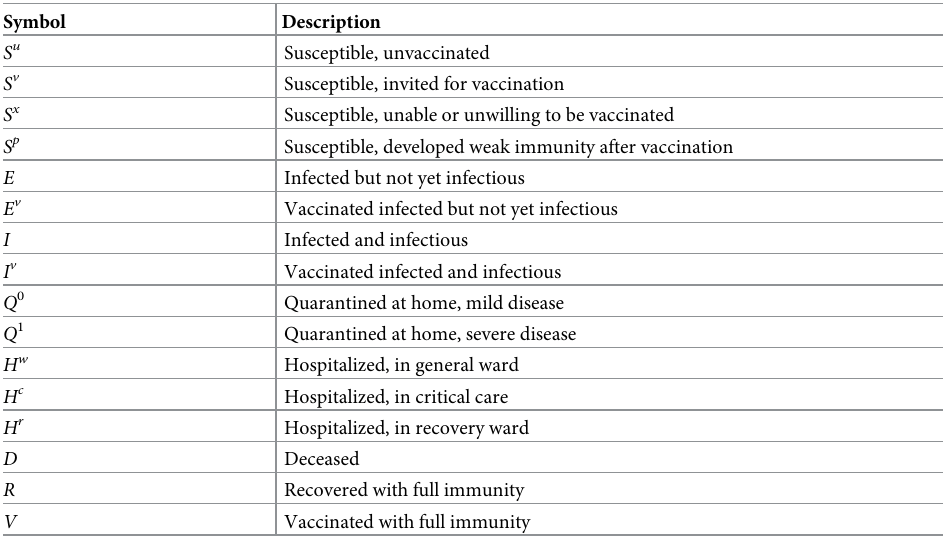
Table 1. Epidemiological compartments. There are KG copies of each compartment, denoted S u regions k = 1, ... , K and age groups g = 1, ... , G .